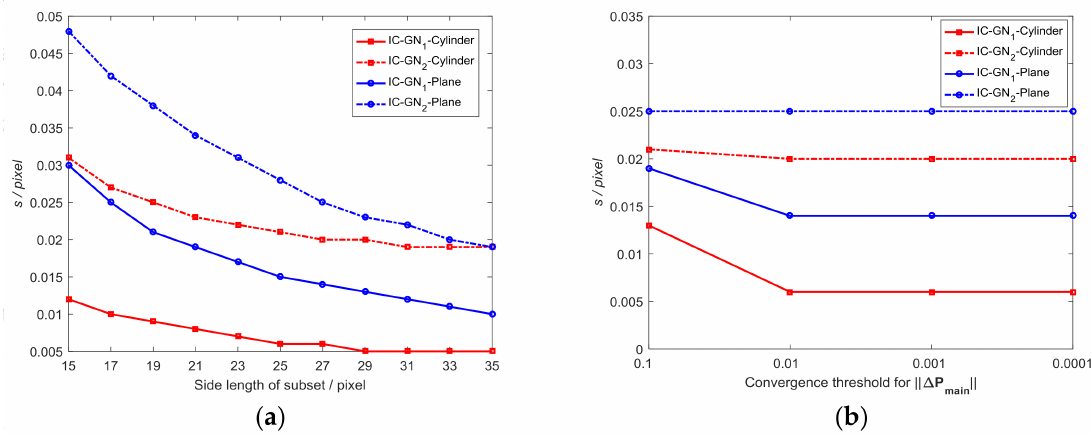
Figure 9. Comparisons of IC-GN 1 and IC-GN 2 by the standard deviations of plane fitting and cylinder surface fitting: ( a ) Comparison with the change of subset size; and ( b ) Comparison with the change of convergence threshold.